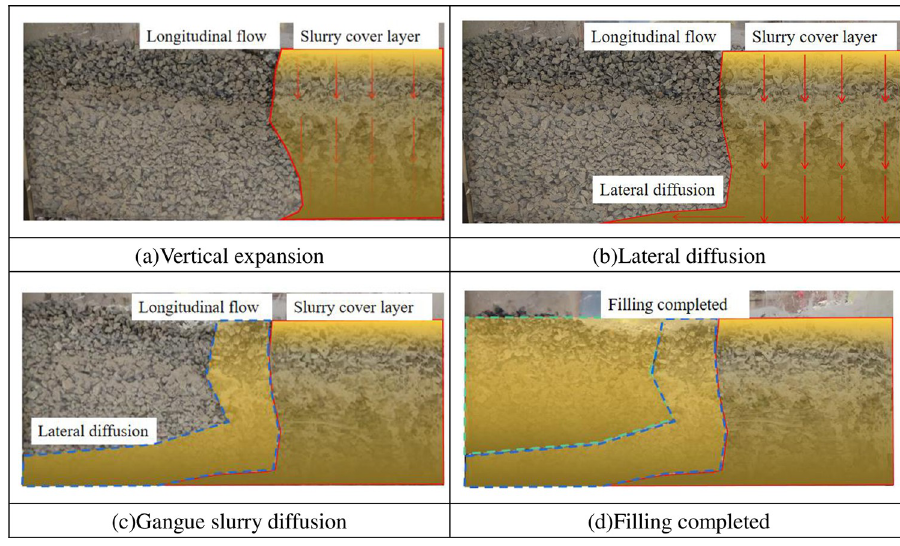
Fig 8. Flow process of gangue slurry in gangue accumulation. (a) Vertical expansion. (b) Lateral diffusion. (c) Gangue slurry diffusion. (d) Filling